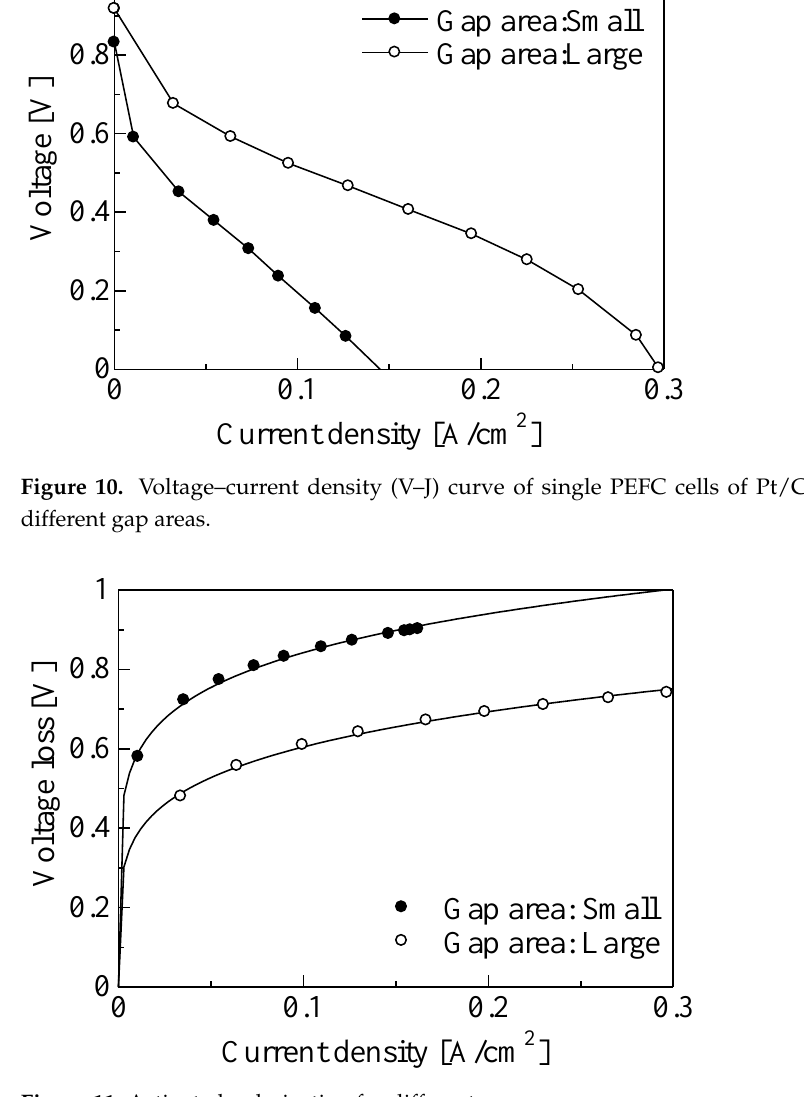
Figure 12. Diffusion polarization for different gap areas.